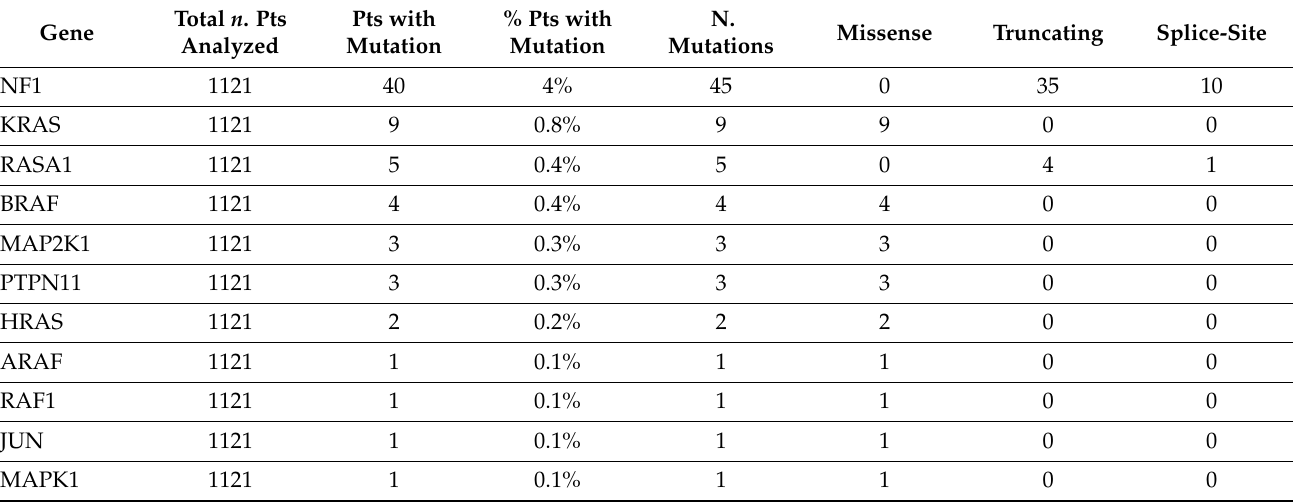
Table 5. Mutations of RAS/RAF/MEK/ERK pathway genes in metastatic breast cancer samples of 1121 patients from two studies (MSKCC and INSERM).